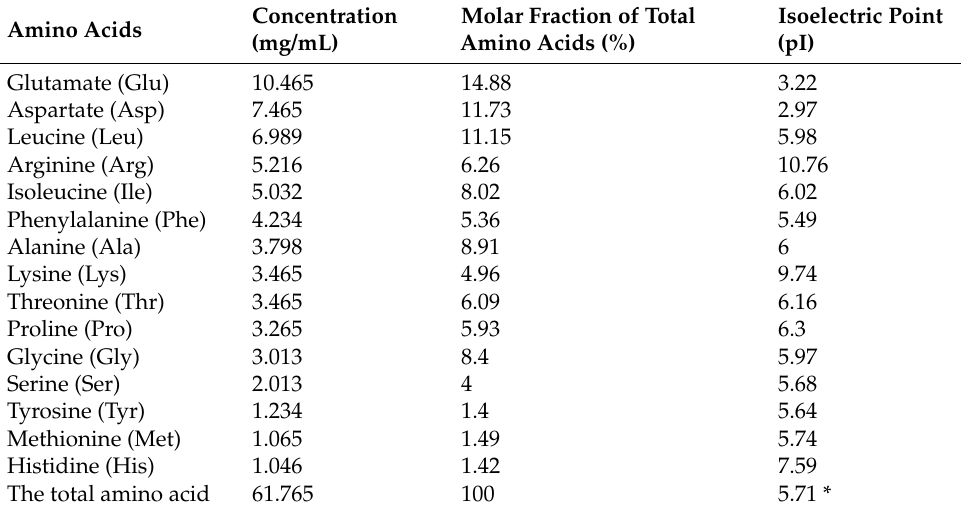
Table 3. The weighted average of amino acid isoelectric